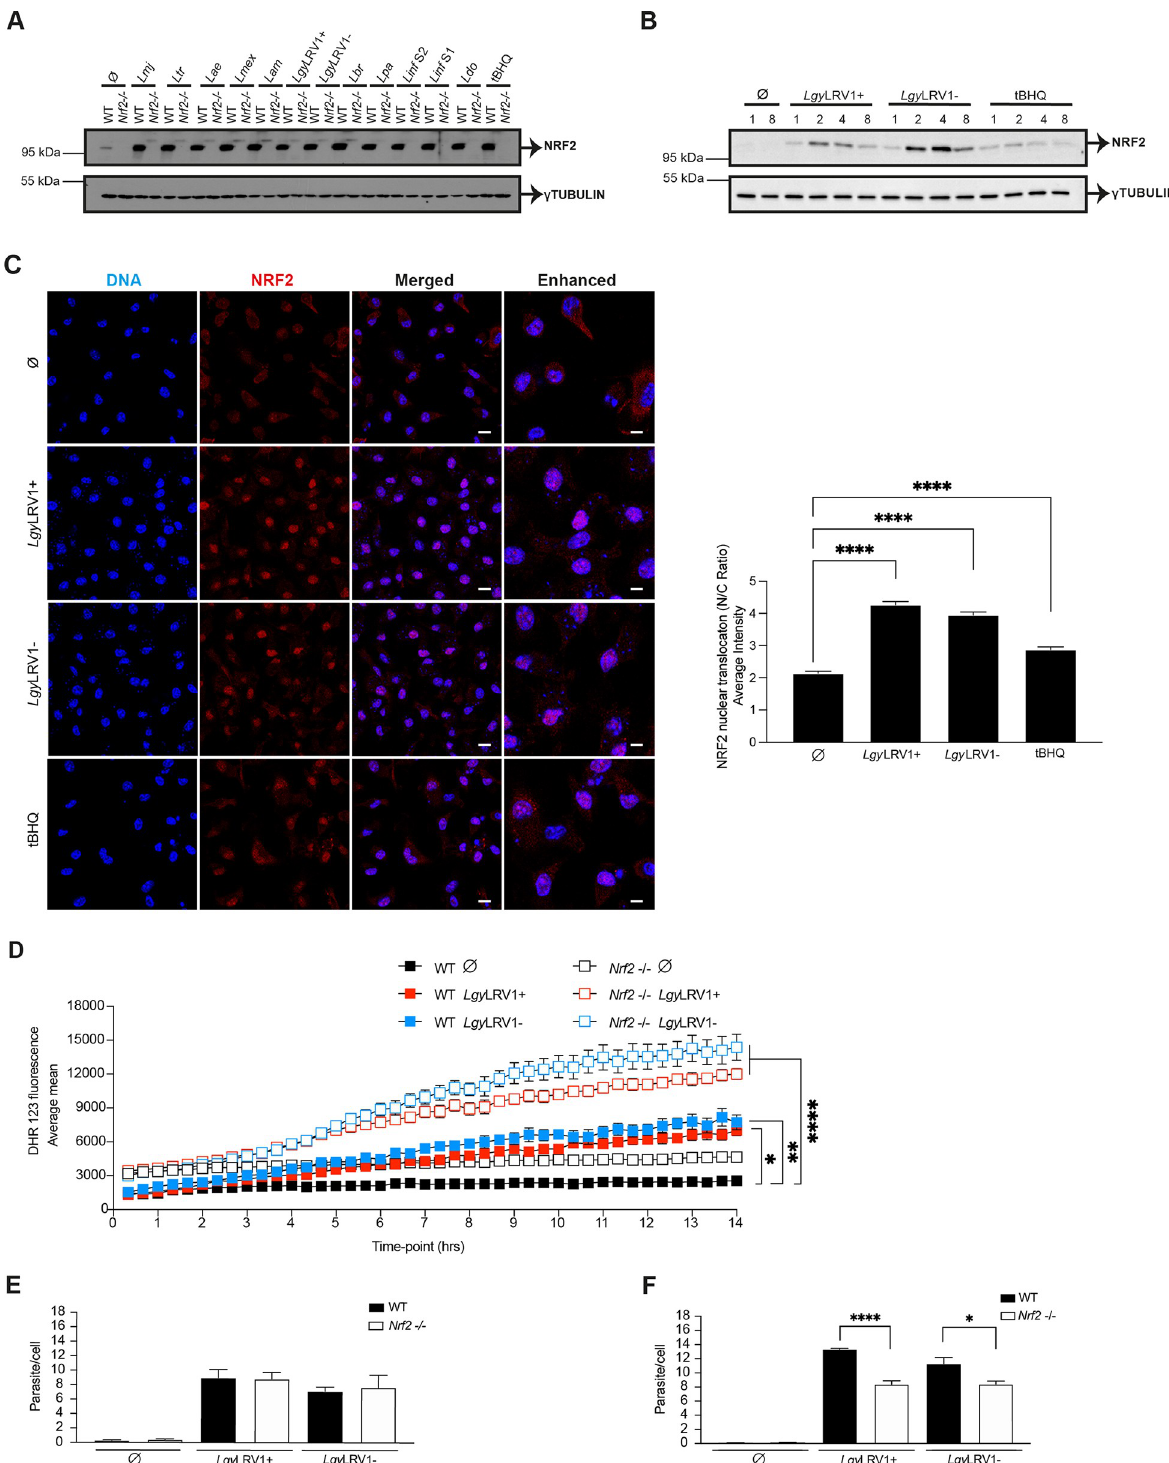
Fig 1. The infection of macrophages with Leishmania spp . leads to upregulation of NRF2 pathway. A) Western blot analysis of WT and Nrf2 -/- BMDMs infected with Lmj , Ltr , Lae , Lmex , Lam , Lgy LRV1+, Lgy LRV1-, Lbr , Lpa , Linf S1, Linf S2 or Ldo parasites for 4 hrs. Analysis of non-treated ( Ø ) or tBHQ-treated (10 μ M) cells were performed concomitantly. Cells lysates were tested with anti-NRF2 and anti- γ TUBULIN antibodies. B) WT BMDMs infected with Lgy LRV1+ or Lgy LRV1- parasites for 1, 2, 4 or 8 hrs, or stimulated with medium ( Ø ), or tBHQ (10 μ M) were analyzed by